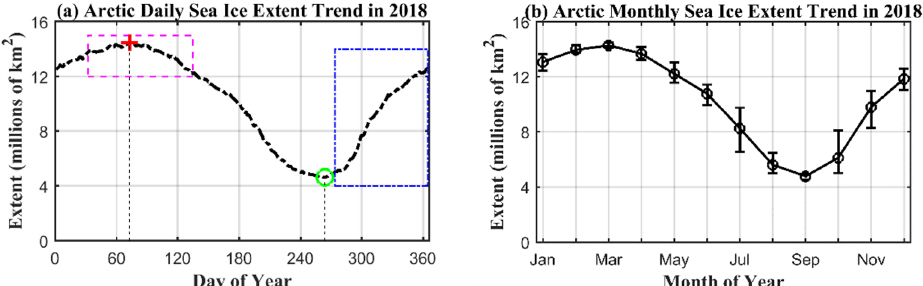
Figure 16. ( a ) Arctic daily sea ice extent trend in 2018. The average sea ice extent per month is depicted by the blue circle. The maximum and minimum sea ice extent are marked by a red cross-section and green circle. The data used in this study are collected during two periods which are marked by magenta and blue rectangles, respectively. The data availability during the first period (February to May) is marked by red dots in the magenta rectangle. The data availability during the second period (October to December) is marked by blue dots in the blue rectangle. ( b ) Arctic monthly sea ice extent trend in 2018. The upper and lower value of the error bar represents the maximum and minimum sea ice extent per month. Sea ice extent data are obtained from the National Snow and Ice Data Center on 15 August 2021 (NSIDC, https://nsidc.org/data/seaice_index/archives, accessed on 11 September